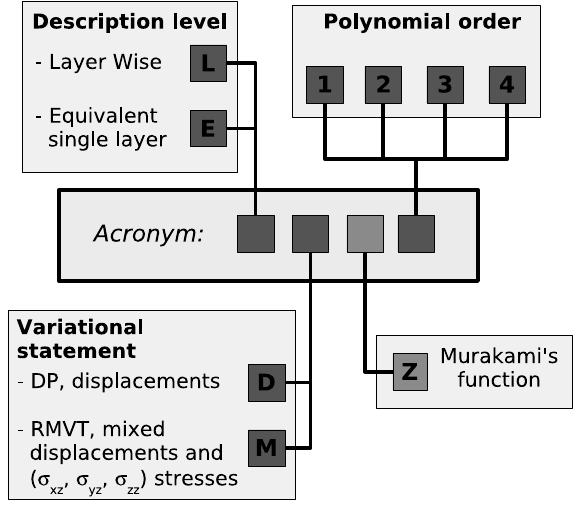
Fig. 5. Acronym system.